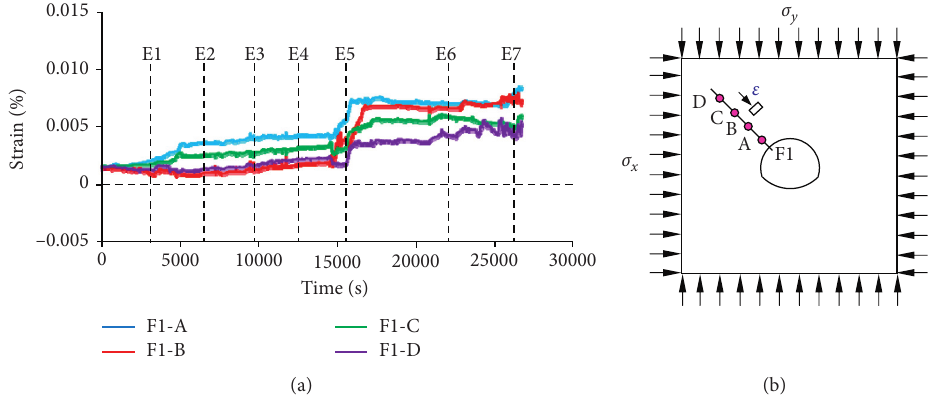
Figure 13: Evolution of surrounding rocks strains in different depths: (a) the curves of radial strain versus time and (b) taking the monitoring line F1 at left shoulder of the tunnel as an example.